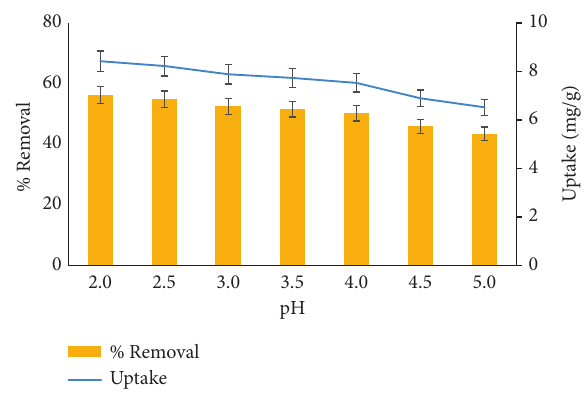
Figure 4: Effect of pH on the sorption capacity and RR120 removal.